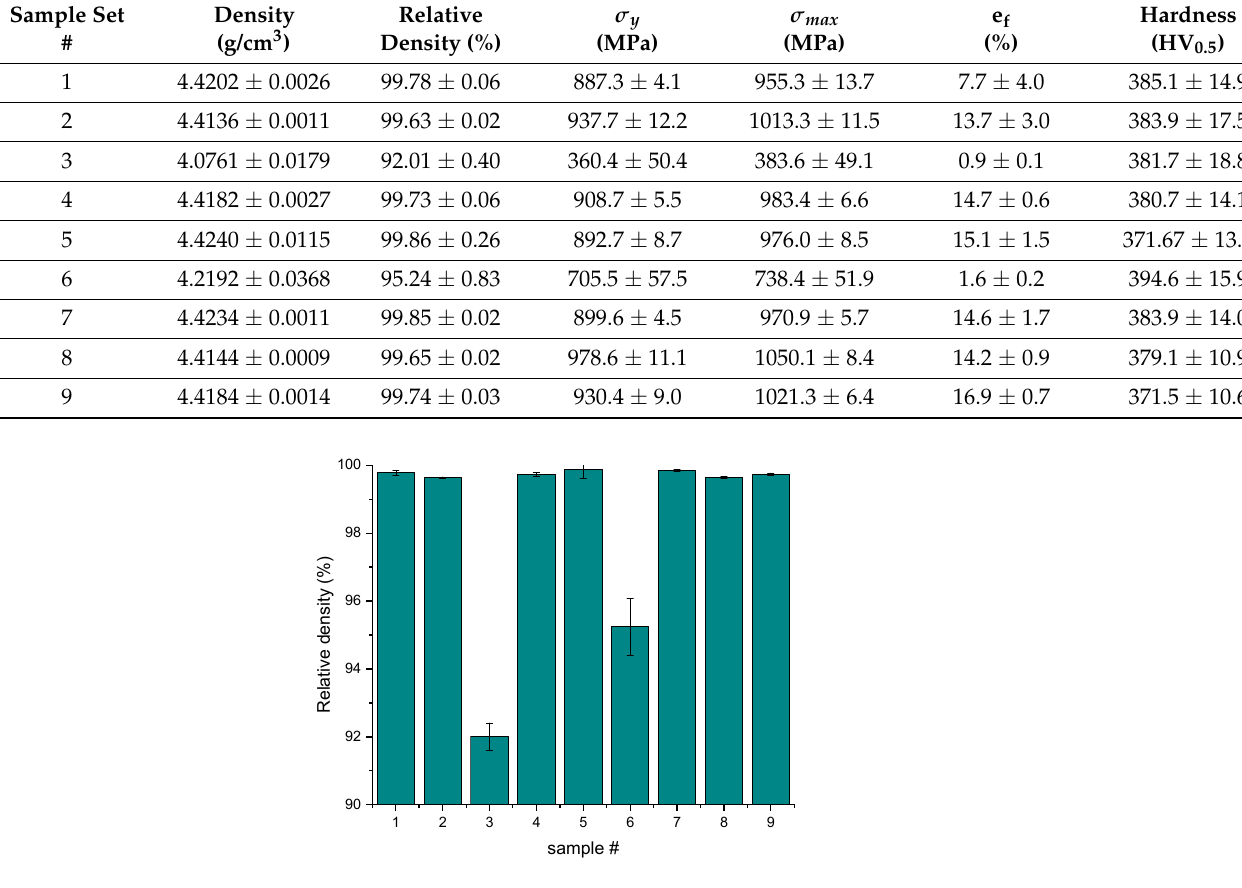
Figure 2. Relative density of samples.